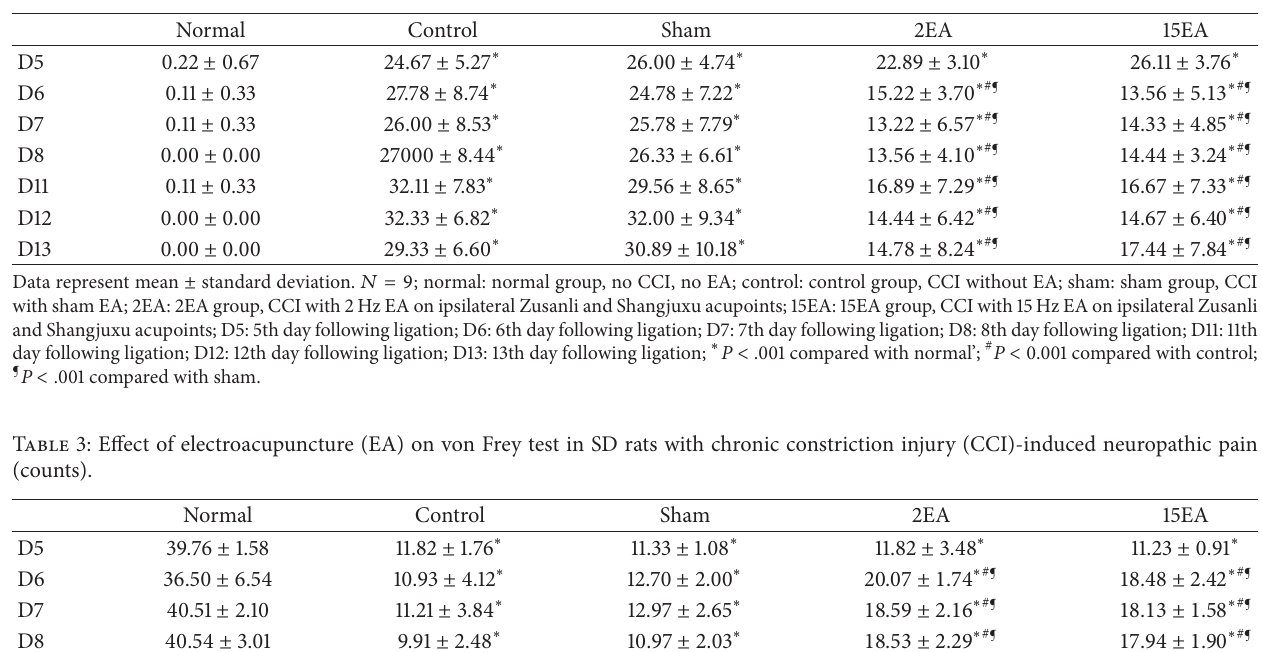
Table 2: Effect of electroacupuncture (EA) on cold plate lift leg test at 4 ∘ C in SD rats with chronic constriction injury (CCI)-induced neuropathic pain (counts).